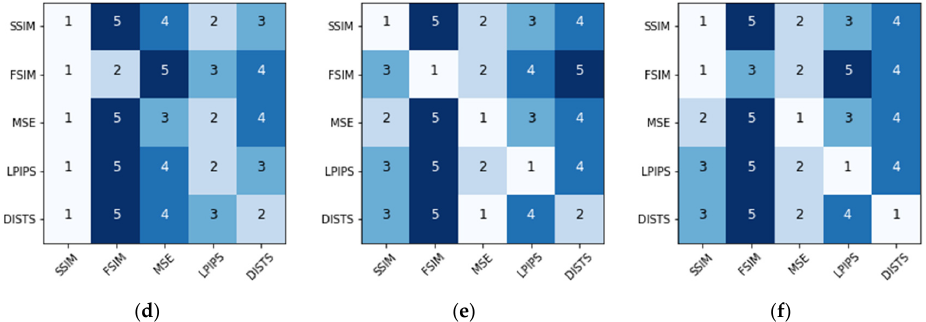
Figure 9. Objective ranking of the restoration results optimized using IQA metrics. The horizontal axis represents the metrics used to train the image restoration network, and the vertical axis denotes the metrics used to evaluate the restoration performance. The number 1 to 5 indicate the rank order from the best to the worst. GAN and TRA mean GAN and Traditional distortions respectively. ( a ) GAN-Pix2pixHD. ( b ) GAN-Pix2pix; ( c ) GAN-CycleGAN; ( d ) TRA-contrast shift; ( e ) TRA-Gaussian blur. ( f ) TRA-speckle noise. Table 3. Statistical analysis on the e ff ect of IQA on the results of image restoration. Unlike SSIM and FSIM, smaller values mean better results in MSE, LPIPS and